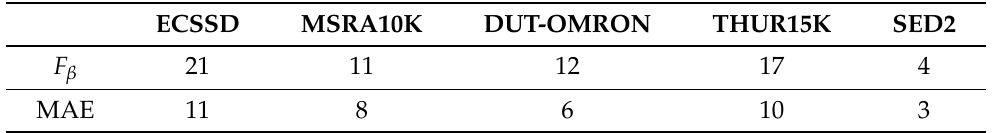
Table 2. Number of models among the 29 state-of-the-art models from Borji et al. [48] outperformed by our model on MAE and F β measure results.